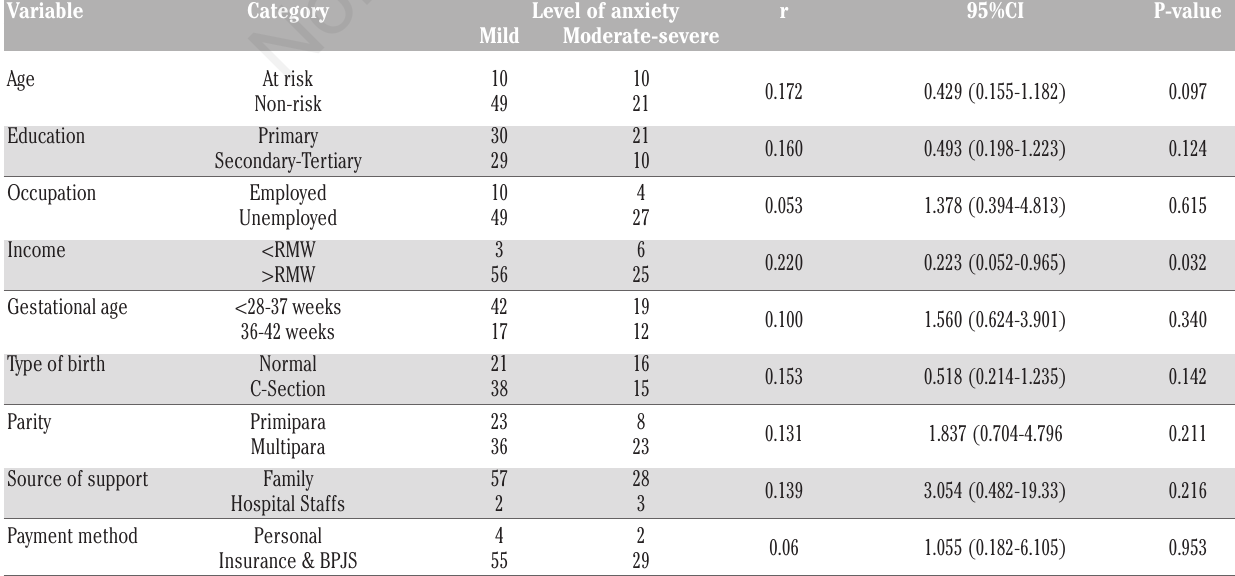
Table 2. The correlation of respondent characteristics to LBW infants mothers’ level of anxiety (n=90).